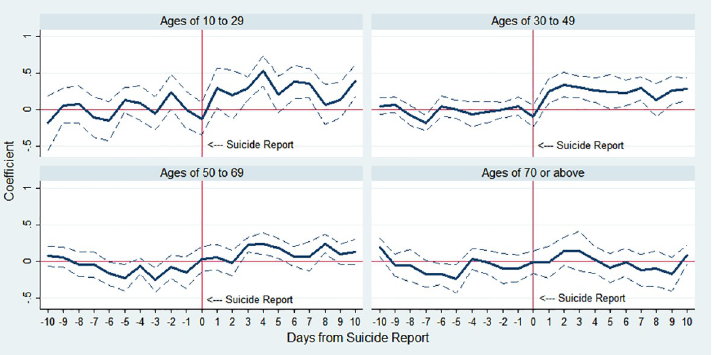
Fig 3. Estimated changes in total suicides by age group before and after celebrity suicide media reports. Note: The y -axis indicates an approximate percent change in public suicide by corresponding day, which is the estimated β k in Eq (1). The dotted lines indicate 95% confidence